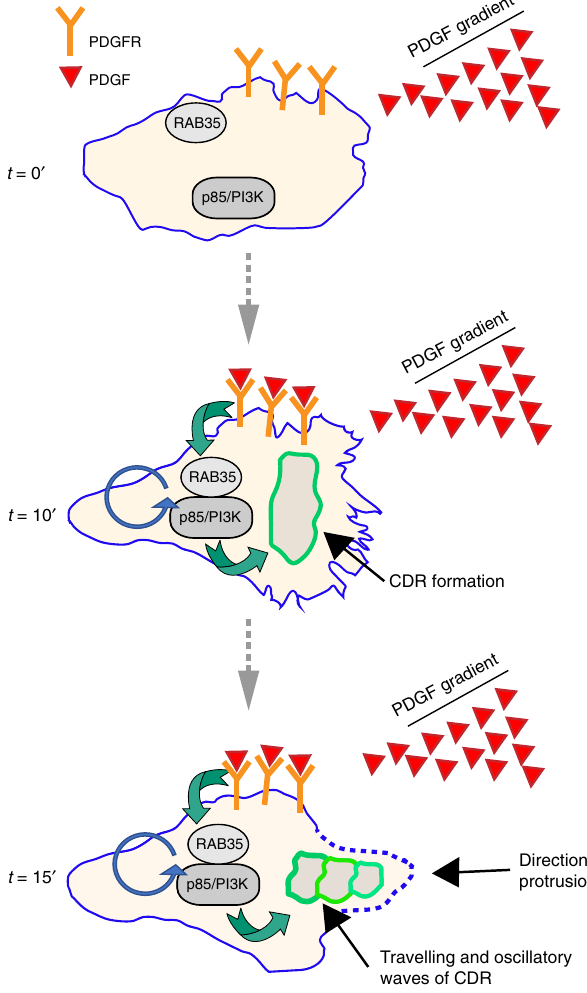
Fig. 9 Model depicting the role of RAB35/p85 – PI3K in CDR formation. Model depicting the role exerted by the RAB35 – p85/PI3K axis in promoting the formation of excitable CDRs required to steer cells in response to PDGF (or HGF) stimulation. Top panel depict a mouse embryo fi broblast not exposed to PDGF gradients. RAB35 and p85/PI3K are not interacting. Middle panels, after few minutes upon exposure to PDGF (or HGF not depicted) gradients, PDGFR activation ensue, leading to the rapid formation of a RAB35 – p85/PI3K complex. This cause the activation of PI3K that act upstream of RAC1 (not depicted) leading to the formation of apically localized CDRs. Lower panels, CDRs kinematics display a behaviour of oscillating and recurrent wave that travels along or expand